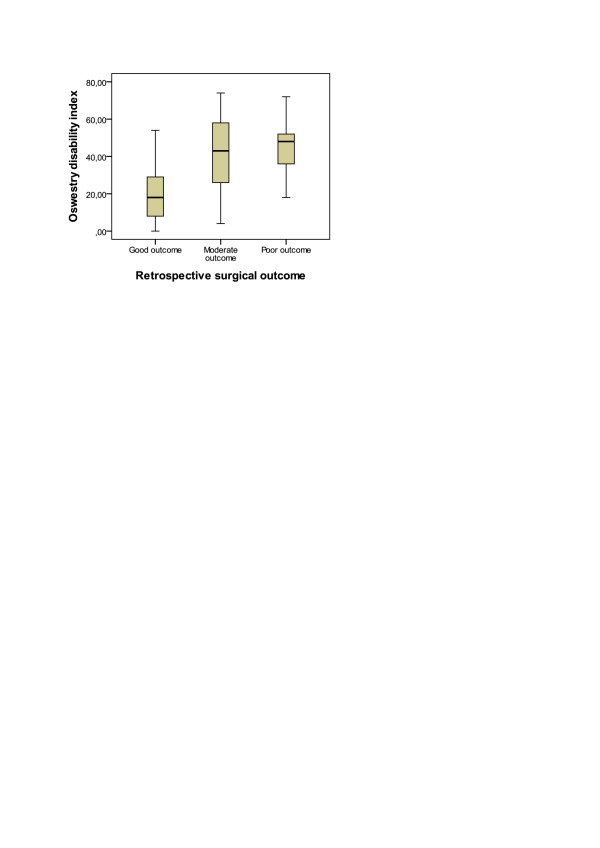
Correlation of retrospective 3-point surgical outcome and baseline prospective Oswestry disability index.